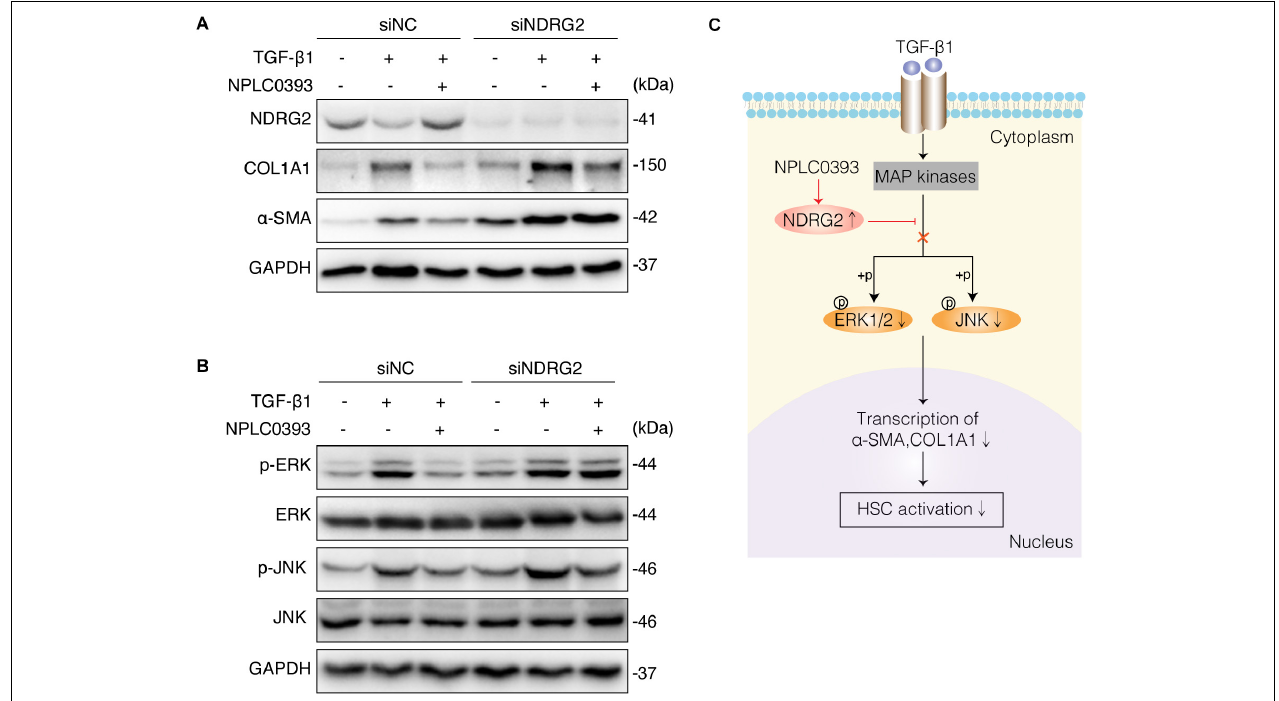
FIGURE 5 | The role of NDRG2 in mediating the antifibrotic effects of NPLC0393. (A) LX-2 cells transfected with siNDRG2 or siNC for 24 h were treated with NPLC0393 for 24 h and further stimulated with TGF- β 1 for another 24 h. The protein levels of α -SMA and COL1A1 were analyzed by western blotting. (B) LX-2 cells were treated as described above, except that the cells were stimulated with TGF- β 1 for 30 min, and the protein levels of total and phosphorylated ERK1/2 and JNK were analyzed by western blotting. (C) Schematic showing the mechanism underlying the protective effect of NPLC0393 against hepatic fibrosis. NPLC0393 inhibits TGF- β 1-induced downregulation of NDRG2. In turn, NDRG2 upregulation disrupts the transcription of α -SMA and COL1A1 by inhibiting TGF- β 1-mediated phosphorylation of ERK and JNK, thereby preventing HSC